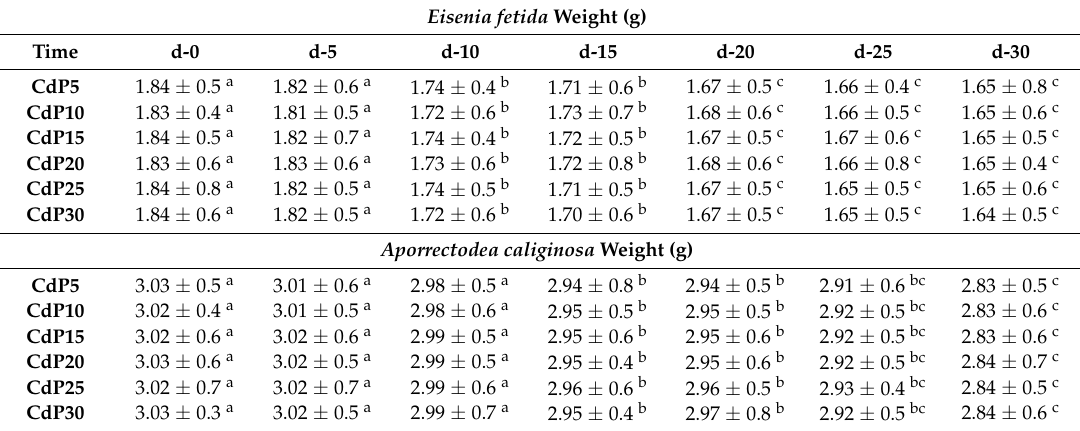
Table 2. Effect of Cd LC50 values under different phenanthrene concentration on earthworm body weight loss with the respect to the time. Eisenia fetida Weight (g)